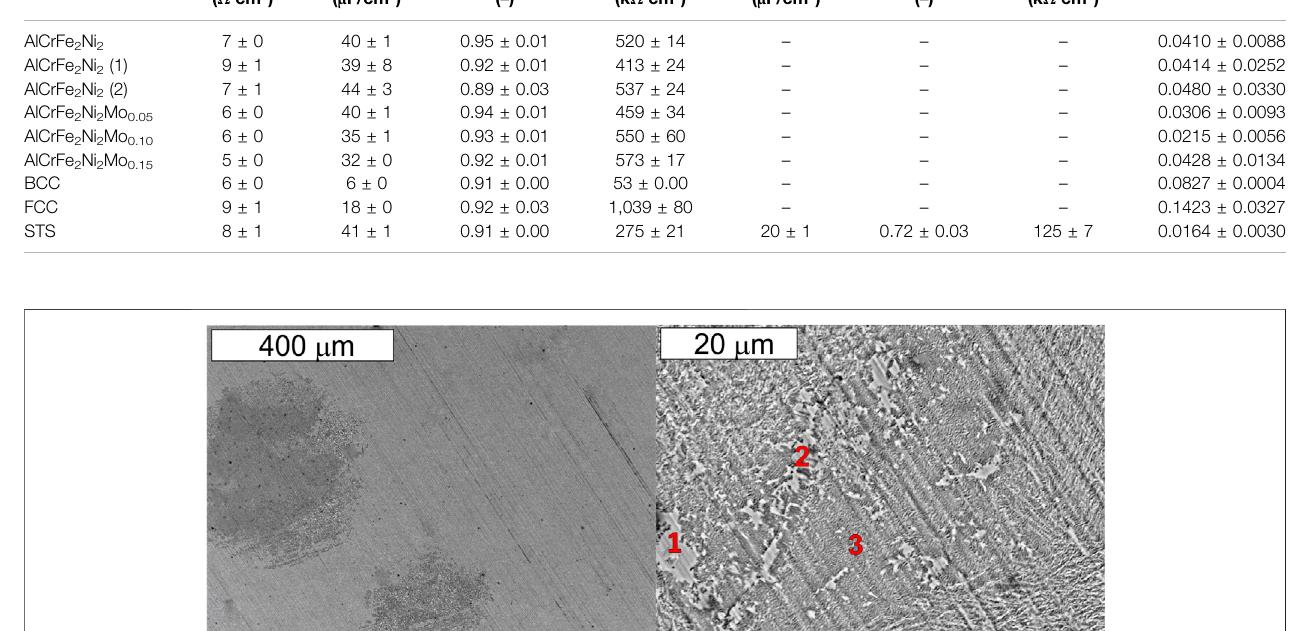
TABLE 3 | Fitted parameters for the elements of equivalent circuits. Sample